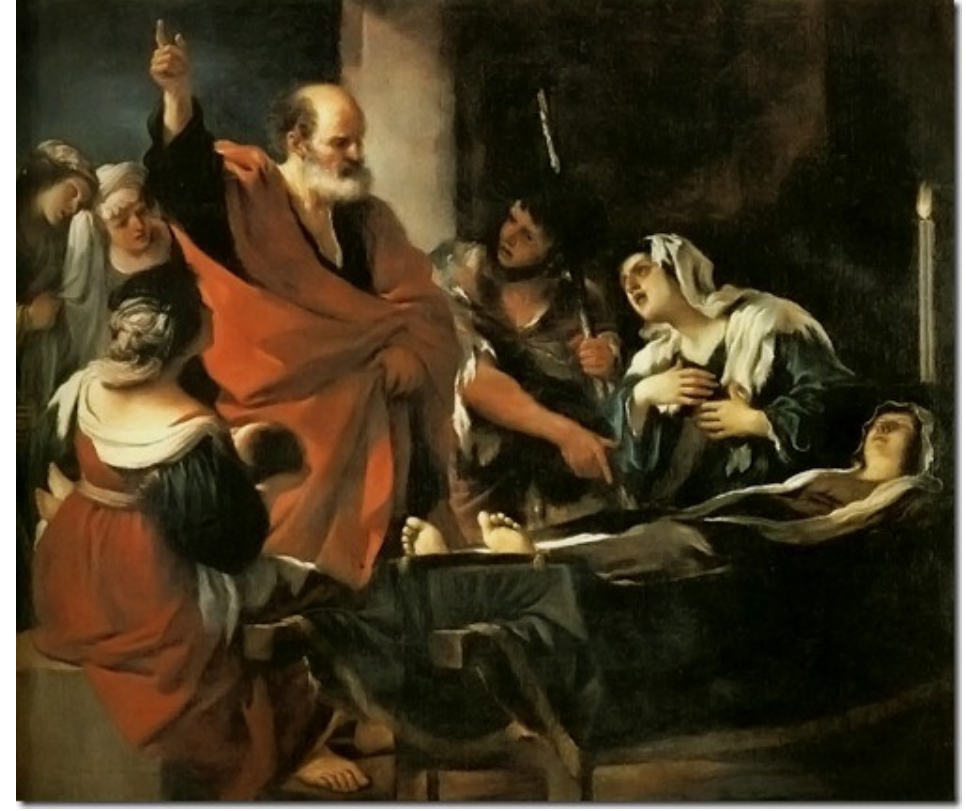
Figure 3. Guercino, Raising of Tabitha , 1618, Palazzo Pitti, Florence. Photo: Wikimedia Commons, Public Domain.